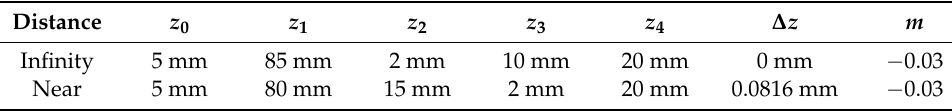
Table 1. The initial distance between lens groups.